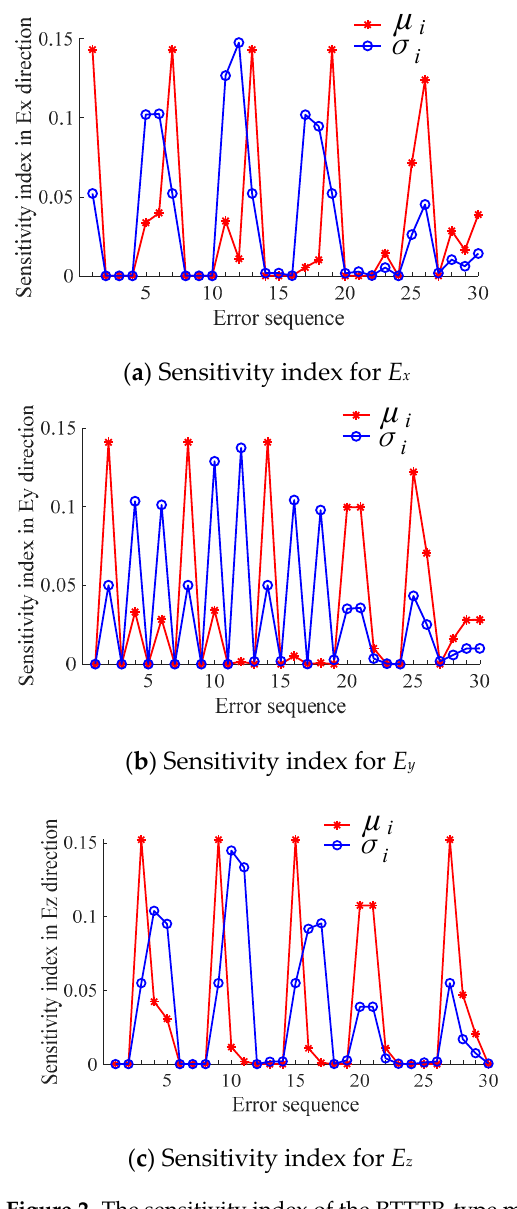
Figure 2. The sensitivity index of the RTTTR-type machine tool.